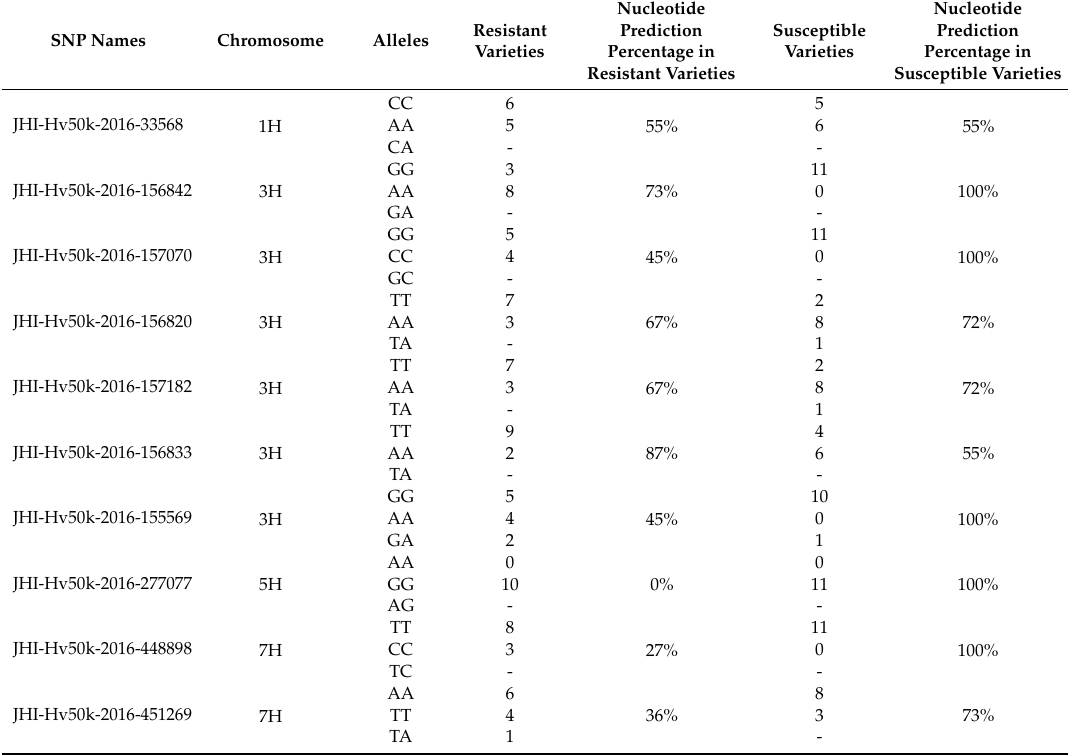
Table 4. Correspondence of the allelic state of markers and the phenotypic reactions to infection with spot